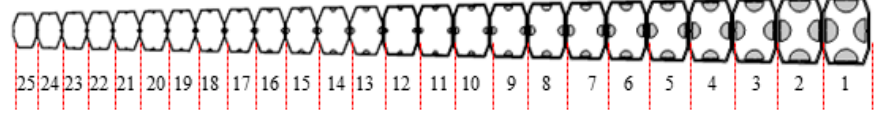
Figure 17. The laying unit of PM acoustic stealth cloak with carbon fiber lining from the 13th layer to the 25th layer.